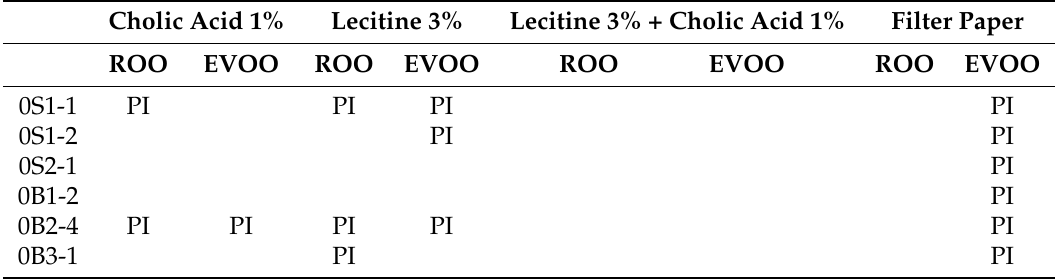
Figure 6. Bar plots of the number of strains with full growth or partial inhibition under refined olive oil; ( a ) according to diet (Fisher’s exact test p = 0.0692); ( b ) paired data analysis of strains isolated from BT (McNemar’s test p = 0.0040), ROO (McNemar’s test p = 0.0019) and SD (McNemar’s test p = 0.062). SD, standard diet; BT, butter enriched diet; EVOO, extra virgin olive oil enriched diet; ROO, refined olive oil enriched diet. Table 4. Refined (ROO) and virgin olive oil (EVOO) antimicrobial activity. PI: Partial